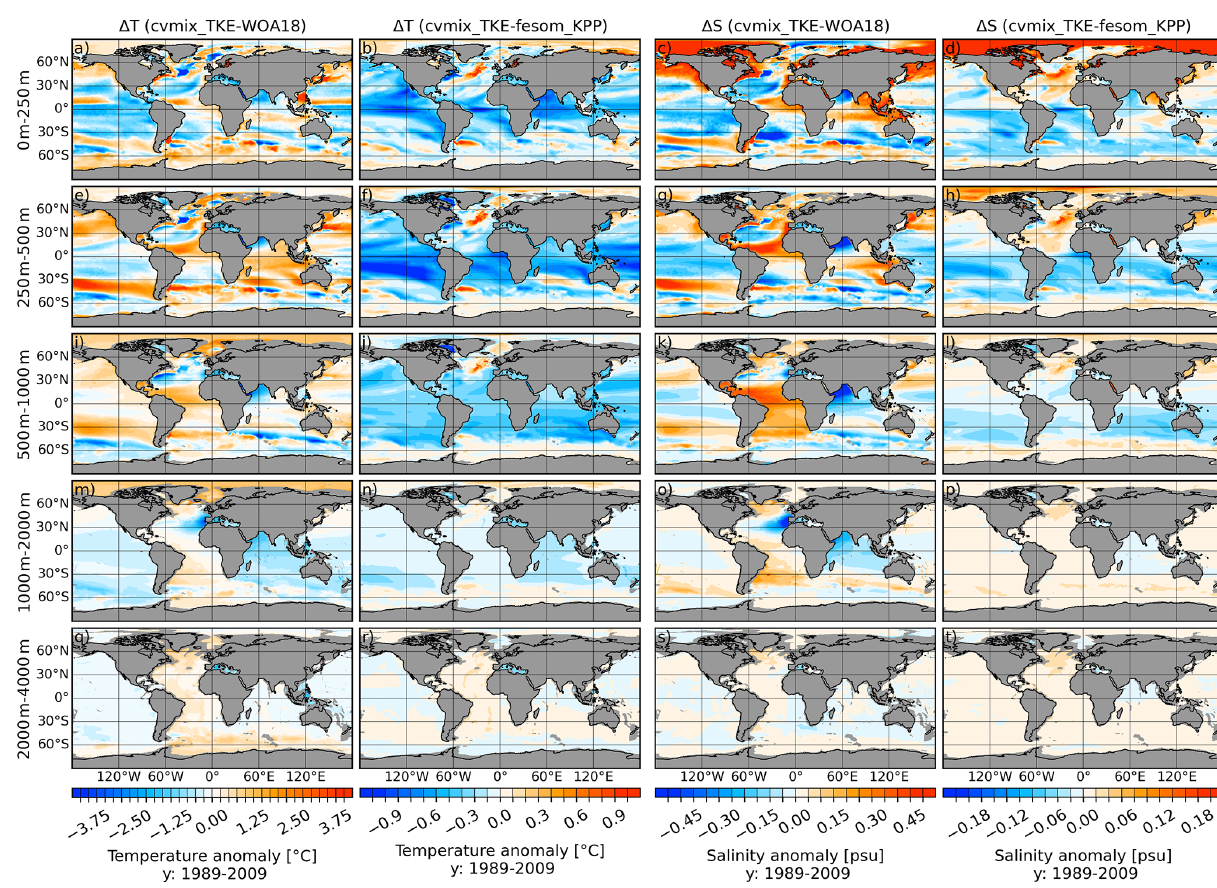
Figure 16. Temperature ( a, e, i, m, q ) and salinity ( c, g, k, o, s ) difference between cvmix_TKE and WOA18 as well as temperature ( b, f, j, n, r ) and salinity ( d, h, l, p, t ) anomaly between cvmix_TKE and fesom_KPP averaged for the period 1989 to 2009. The panels show, from top to bottom, the vertically averaged fields for the depth ranges of 0–250, 250–500, 500–1000, 1000–2000 and 2000–4000m.